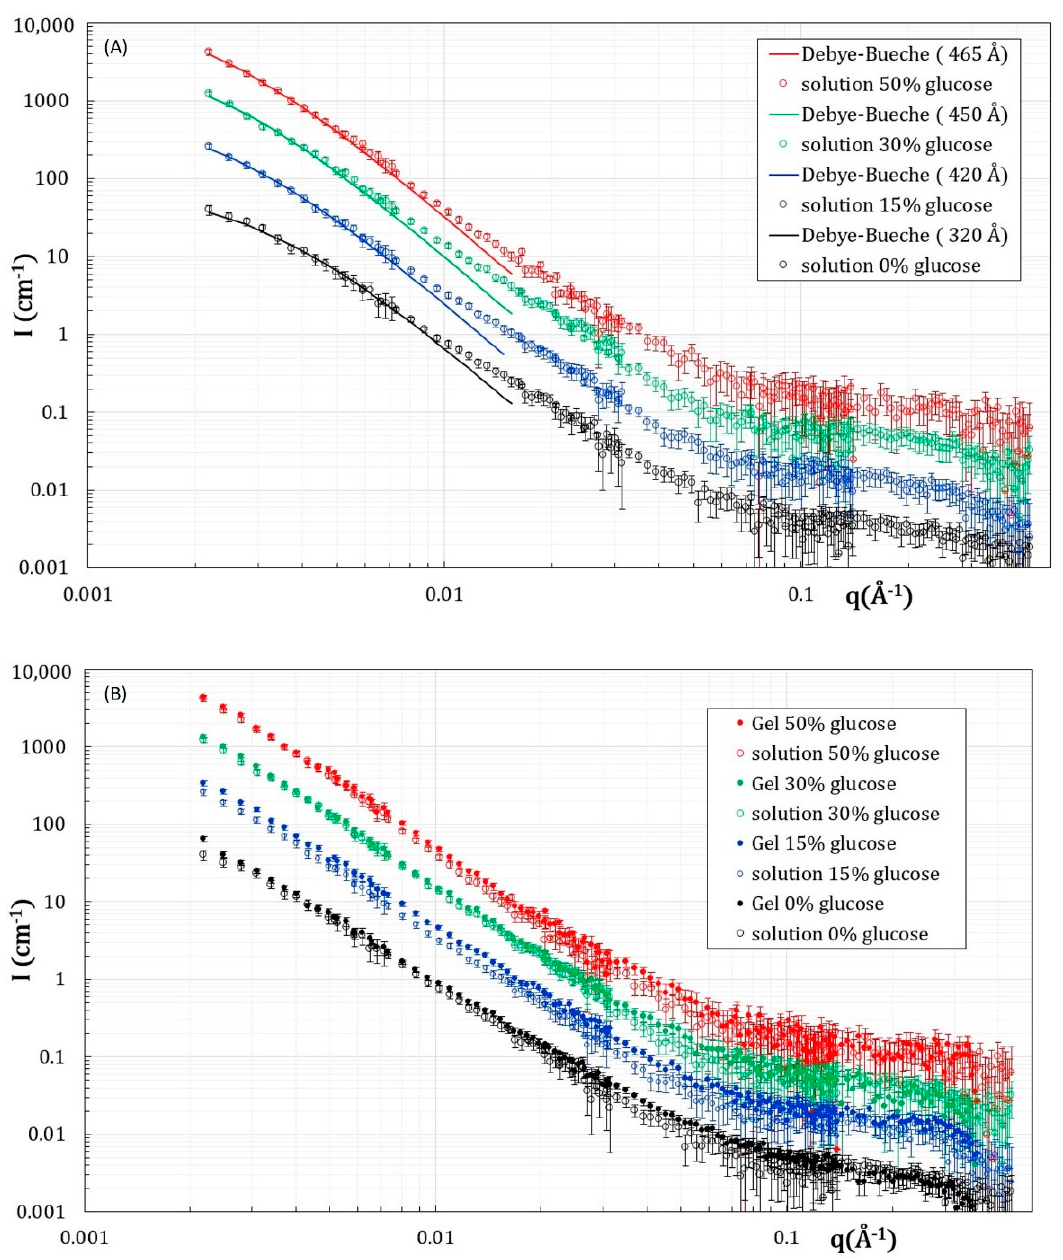
Figure 3. SANS scattering curves for solutions ( A ) and gels ( B ) prepared in D 2 O with deuterated glucose. The data for solutions and gels at 0% glucose are in absolute scale. The other scattering curves are shifted from one to another by a factor of 3.33. The continuous line in ( A ) is a fit of the low q part of the scattering by a Debye–Bueche approach. Errors bars are calculated from standard